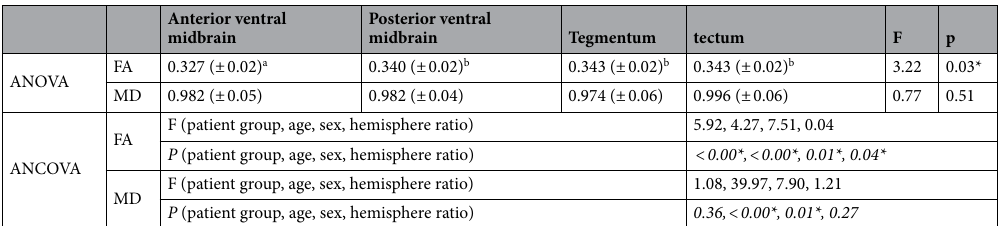
Table 3. Comparison of mean fractional anisotropy levels of four midbrain regions in the patient group. Values represent mean (± standard deviation); FA: fractional anisotropy; MD: mean diffusivity; One-way ANOVA and the LSD post hoc test were used for comparison of diffusion tensor parameter; ANCOVA were used to determine the association between possible confounding factors (age, sex and hemisphere ratio and diffusion tensor parameter. Significant values are italics. *Significant difference between the patient and control groups at the indicated p. LSD test result: a <